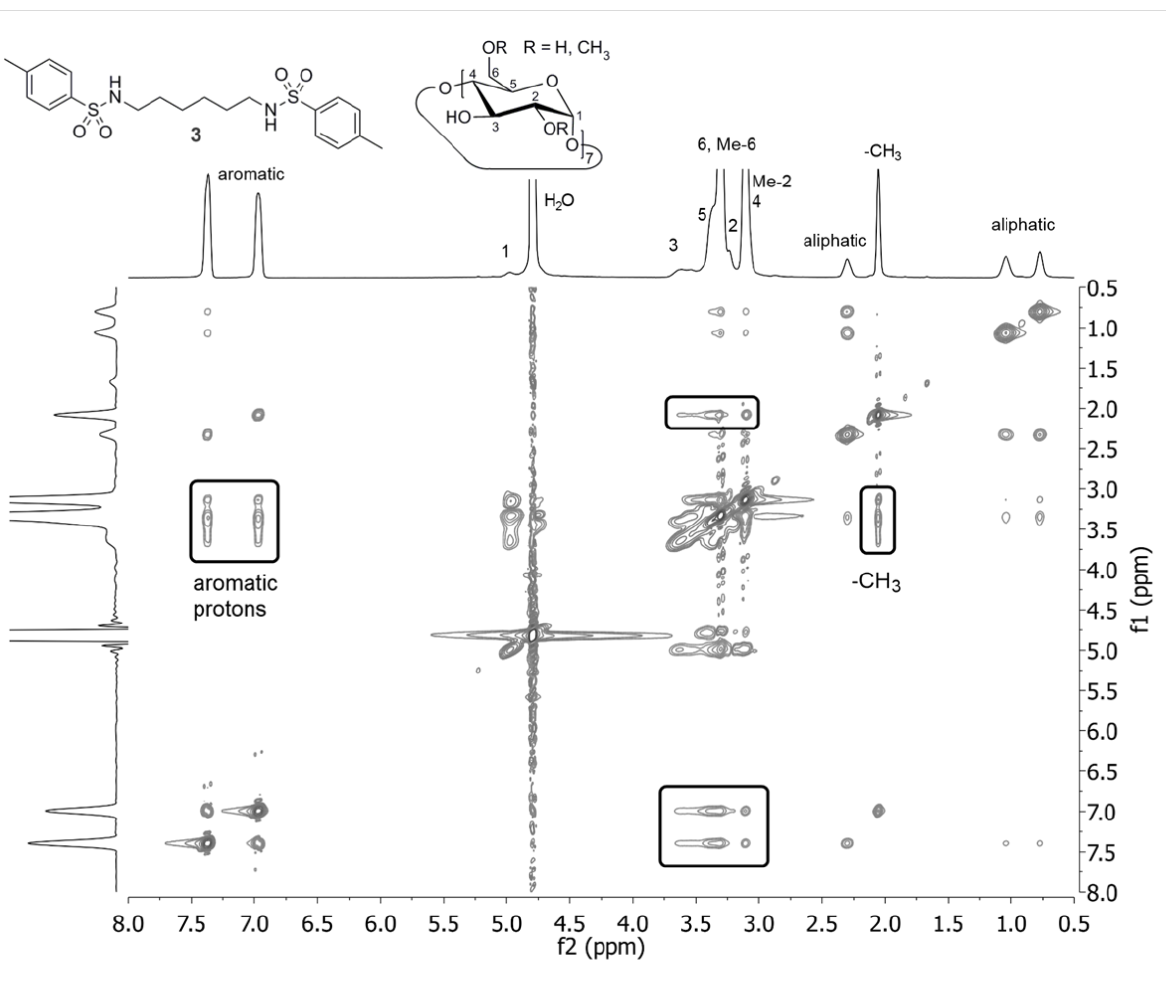
This strongly indicates a self-agglomeration of the tosyl groups of 3 with β -CD. Further confirmation of these findings is a perceivable downfield shifting of the proton signals of 3 β compared to 3 suspended in D 2 O, since they are magnetically shielded by the β -CD